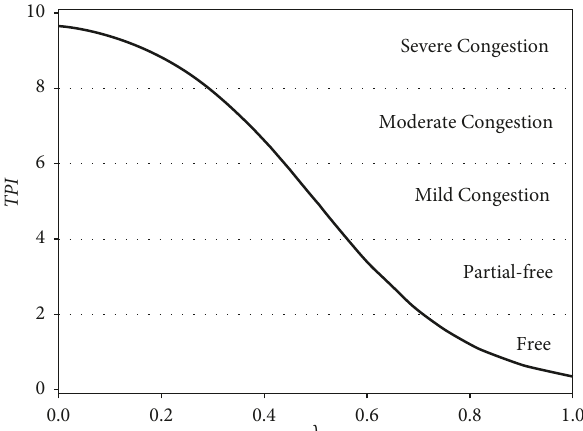
Figure 9: Te changes in road congestion level for diferent ranks in Xi’an. Mapped to a distribution centered at 0.5 in the interval. Te TPI is closer to 0 or 10, and the rate of change of the curve is